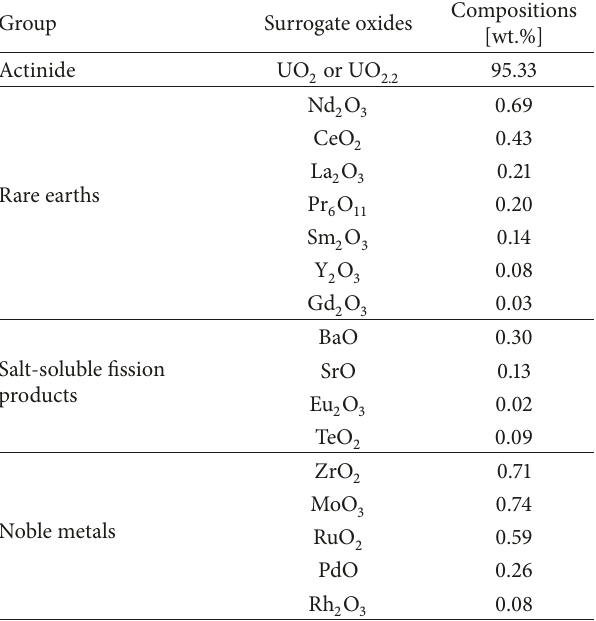
Table 2: Simfuel composition used in this study: each content indicates the surrogate oxides’ weight percentages added in the mixture of the surrogate